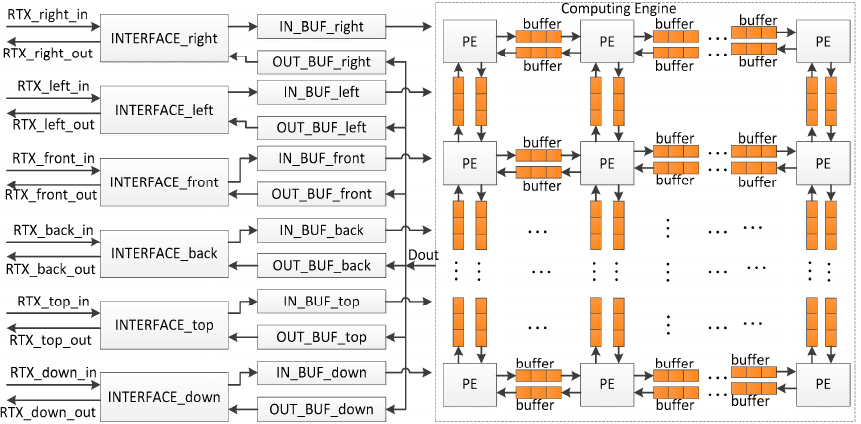
Figure 1. System diagram. Processing element (PE), receiving/transmission (RTX).